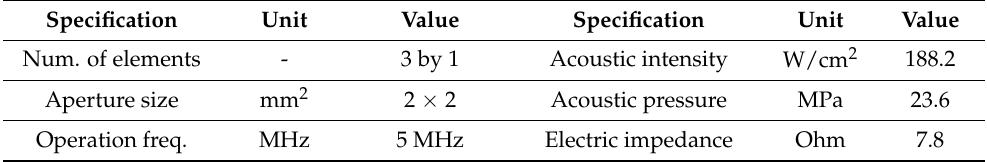
Figure 12. Simulated performance of the 1–3 composite focused ultrasound transducer; ( a ) the acoustic pressure field with respect to the number of the transducer elements, ( b ) the acoustic pressure output and the acoustic intensity with respect to the number of arrays, and ( c ) electric impedance responses with the varying number of active elements in the water media. Table 3. Simulated specification of the designed focused ultrasound transducer.